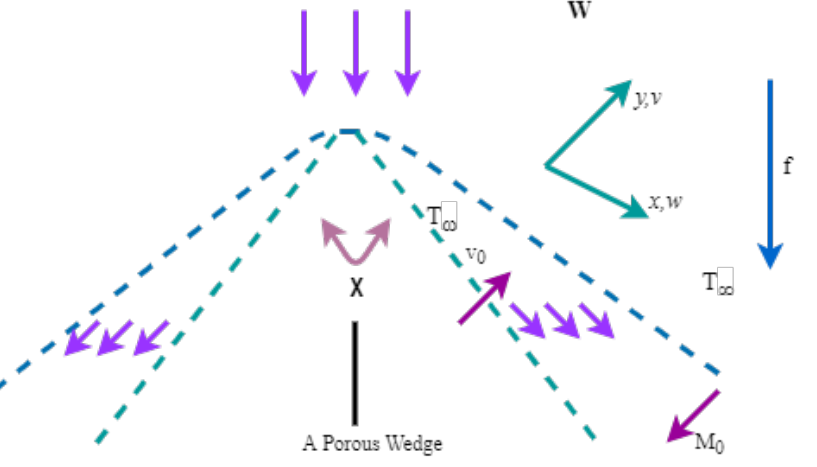
Figure 1. Flow model over a porous wedge